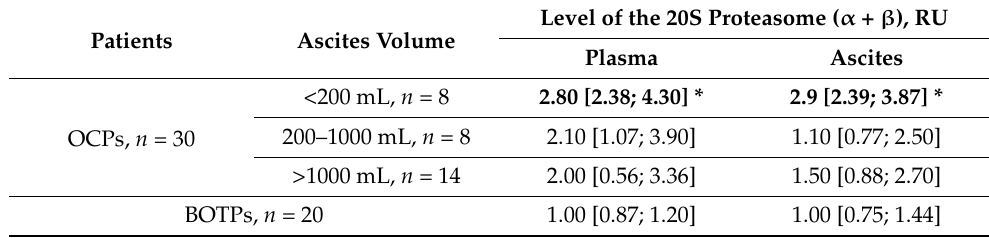
Table 5. The level of 20S proteasome in exosomes from plasma and ascites of ovarian tumor patients.